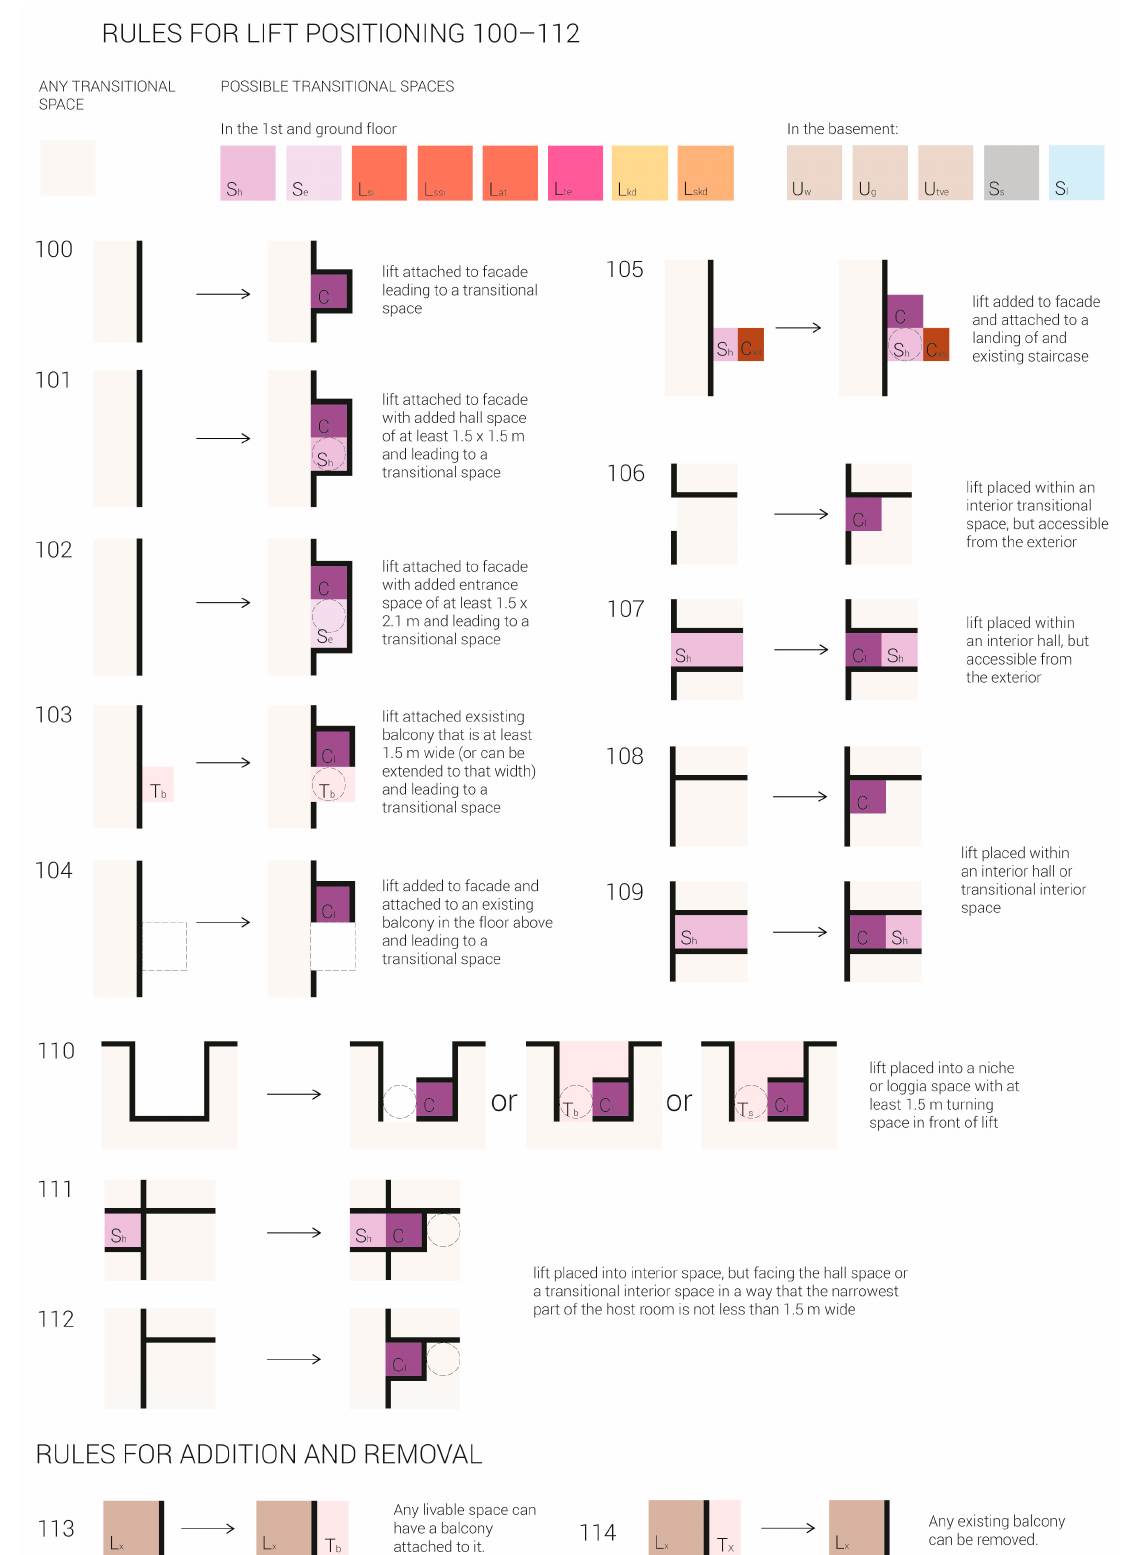
Figure 15. Rules for lift positioning and rules for their addition and removal (Ana Bel č i č , 2022).